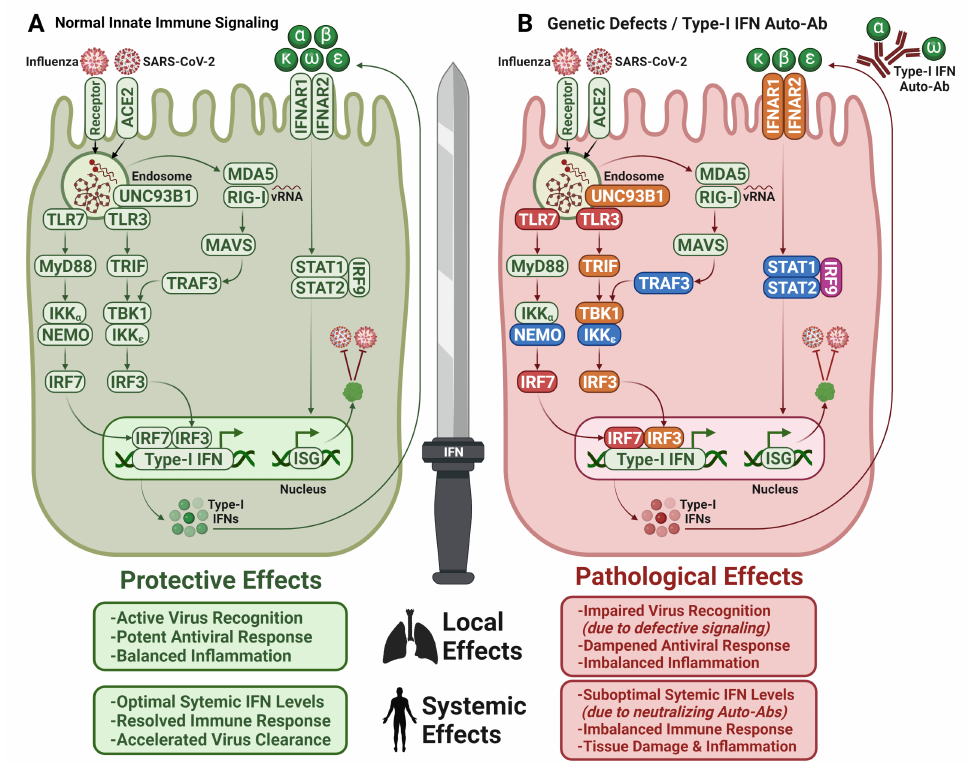
Figure 1. Type I IFNs—a double-edged sword. ( A ) Host proteins and signaling pathways that are involved in virus recognition and antiviral response in healthy individuals. ( B ) Defective IFN- dependent antiviral response in individuals with inborn genetic errors resulting in impaired virus recognition or suboptimal circulating IFN levels due to neutralization by type I IFN Auto-Abs. Non- affected proteins (green), defective proteins that are associated with COVID-19 (red) or influenza pneumonia (orange), SARS-CoV-2 and IAV infections (pink), other viral infections (blue); Normal sig- naling (green arrows), dampened signaling (red arrows). ACE2: Angiotensin-Converting Enzyme 2, TLR: Toll-Like Receptors, MyD88: Myeloid Differentiation Primary Response 88, IKK: Inhibitory